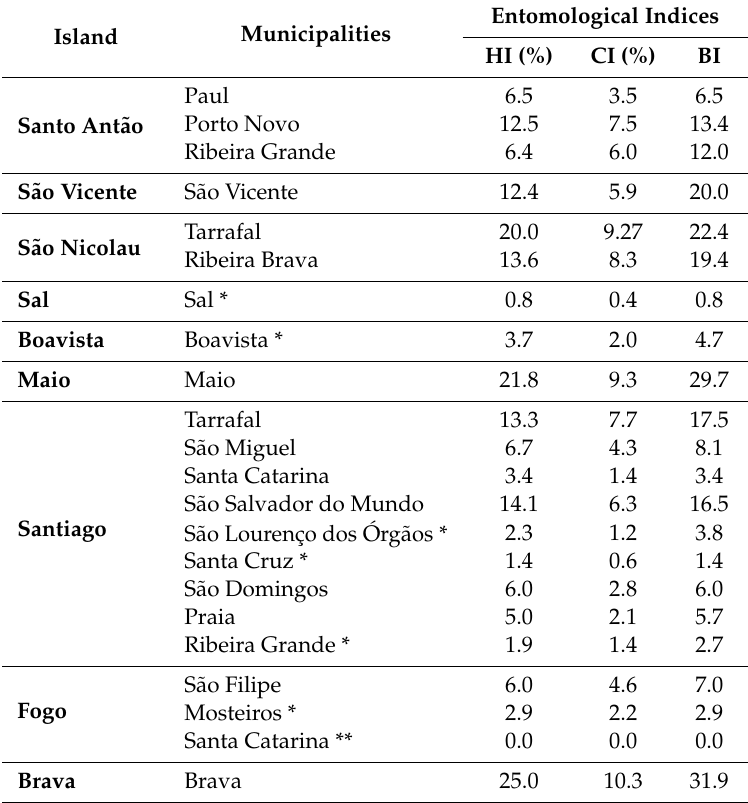
Table 3. Entomological indices in